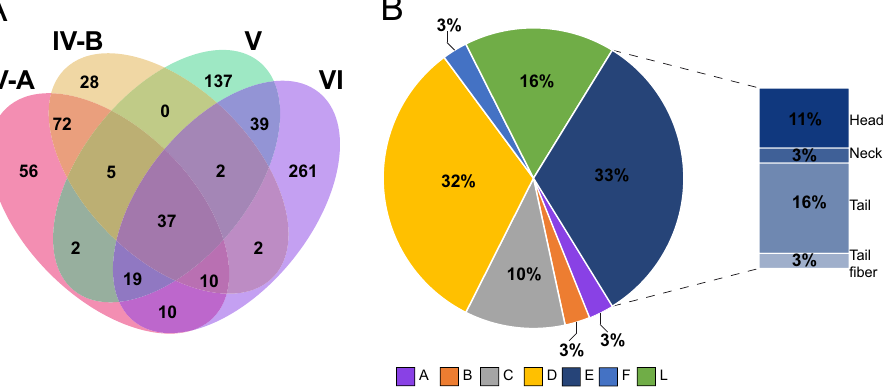
Figure 3. Shared core-clusters analysis. The shared core-clusters between medium (IV-A and IV-B) and large (V and VI) genomes are represented as a Venn diagram ( A ). The 37 core-clusters shared by the medium- and large-size genomes were grouped by functional categories ( B ). The categories are: (A) Transcription, (B) Translation, (C) Nucleotide metabolism, (D) DNA replication, recombination, repair, packaging, and processing, (E) Virion proteins, (F) Chaperonins/assembly catalysts and (L) Others.